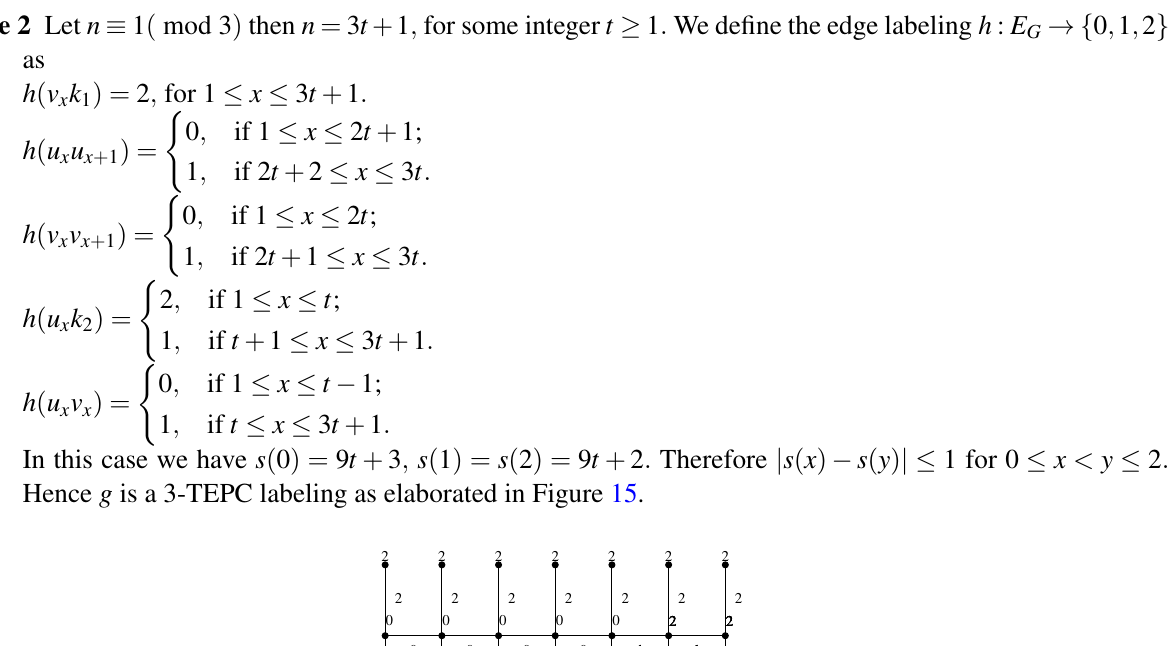
Fig. 14 3-TEPC labeling of graph L 6 (cid:12) 2 K 1